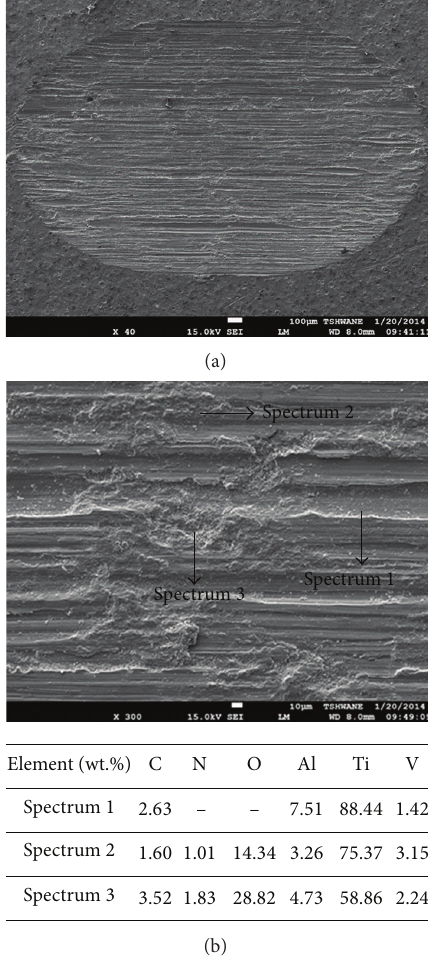
Figure 9: Wear track of the Ti-6A1-4V substrate after sliding against a tungsten carbide